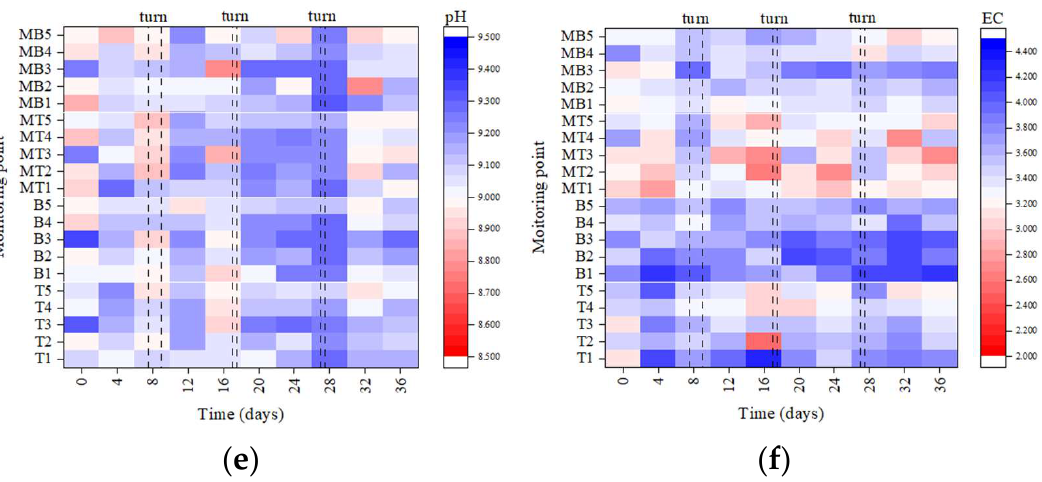
Figure 3. Spatial distribution of moisture content (MC) ( a ), violates solid (VS) ( b ), the ratio of carbon to nitrogen (C/N) ( c ), Germination Index (GI) ( d ), pH ( e ), and electrical conductivity (EC) ( f ) at different monitoring points during aerobic composting. B1–5, the five monitoring points at the bottom of the pile in the non-covered group; T, the five monitoring points at the top of the pile in the non-covered group;). MB1–5, the five monitoring points at the bottom of the pile in the covered group; MT, the five monitoring points at the top of the pile in the covered group.